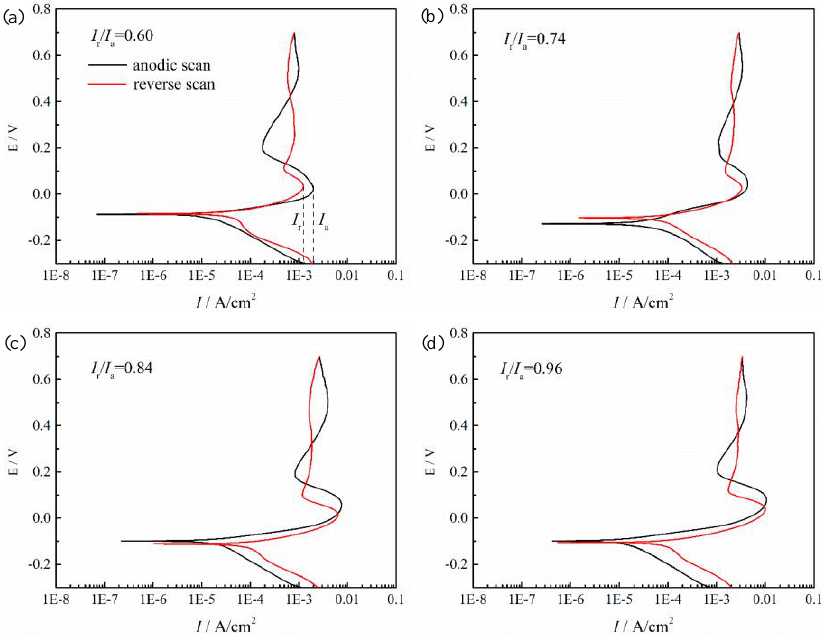
Figure 8. DL-EPR curves of the sensitized samples with 15% ( a , b ) and 40% ( c , d ) cold rolling reduc- tions. ( a , c ) sensitization at 800 °C for 2 h; ( b , d ) sensitization at 800 °C for 8 h.